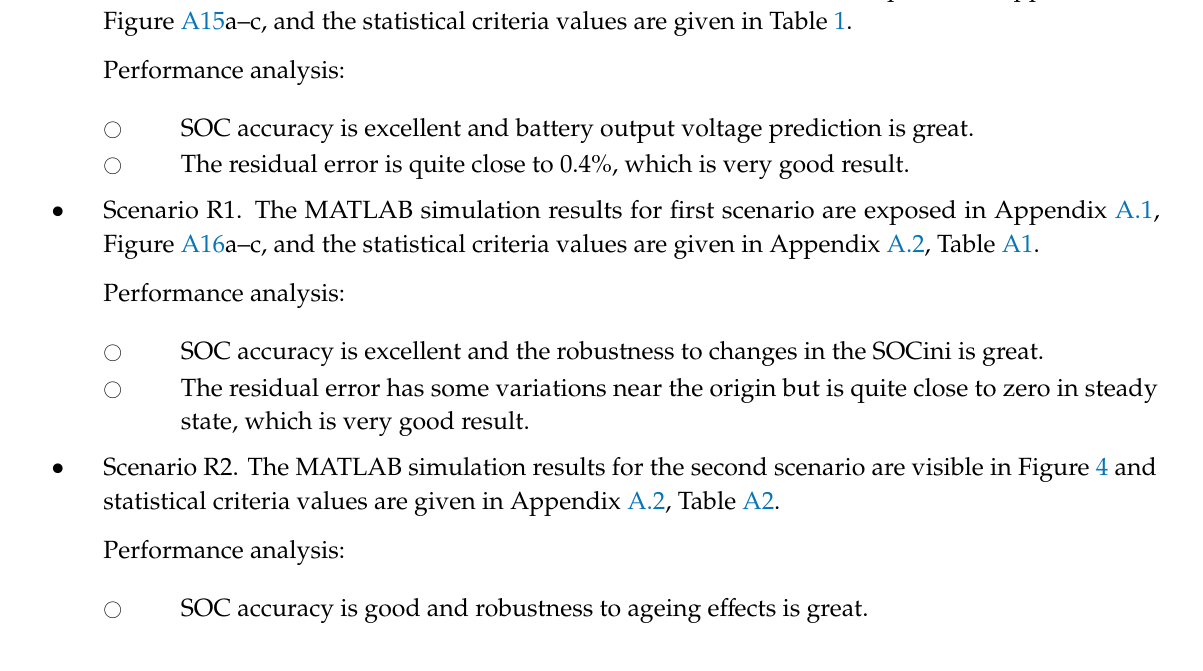
( b ) Figure 4. Robustness to simultaneous changes, SOCini = 1, Qnom = 4.2 Ah (ageing effects); ( a ) AEKF SOC value versus battery model true value; ( b ) SOC residual. Performance analysis: